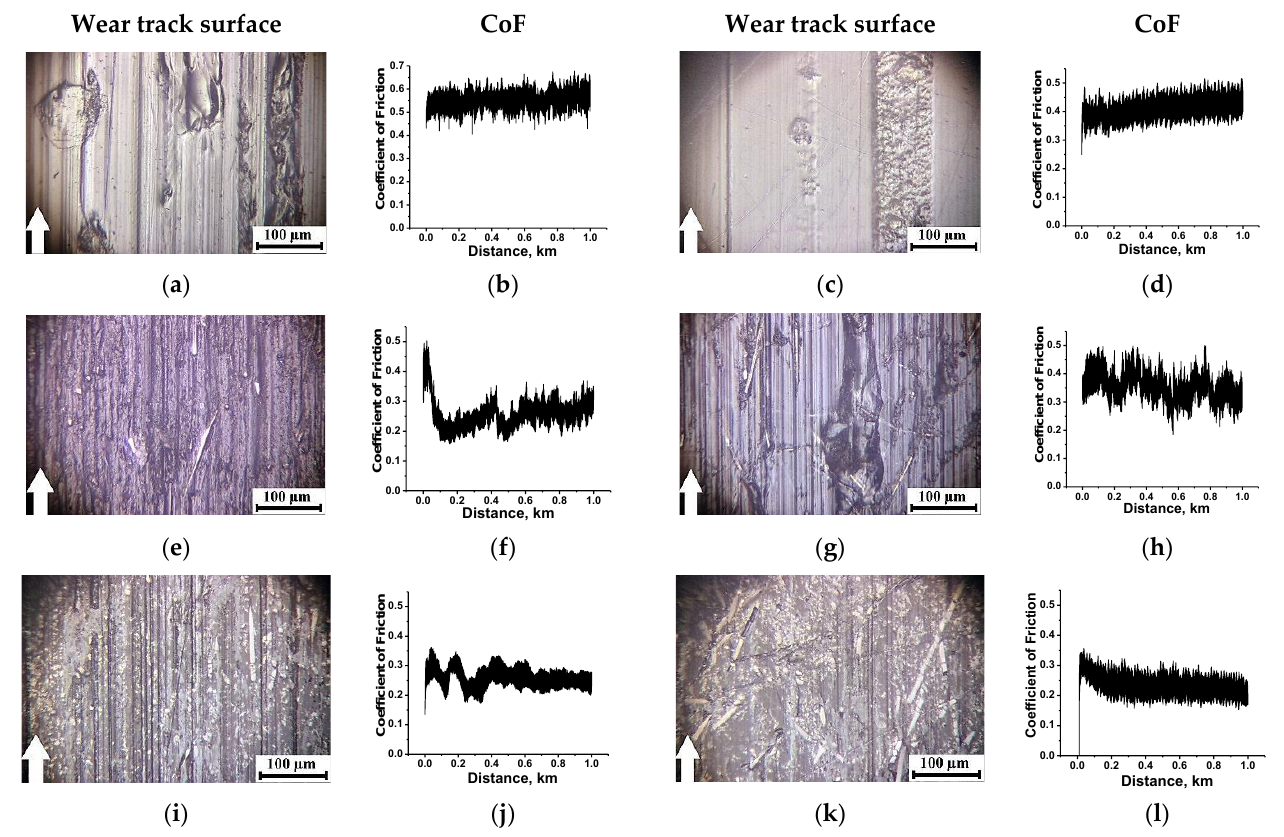
Figure 5. The optical micrographs of the wear track surfaces and the CoF time dependences for both neat PI ( a , b ) and PEI ( c , d ), as well as their PI/10CCF ( e , f ), PI/10CCF/10Gr ( i , j ), PEI/10CCF ( g , h ), PEI/10CCF/10Gr ( k , l ) composites. The metal-polymer tribological contact under the ‘mild’ conditions ( P = 60 N, V = 0.1 m/s). See Figure S3 for more